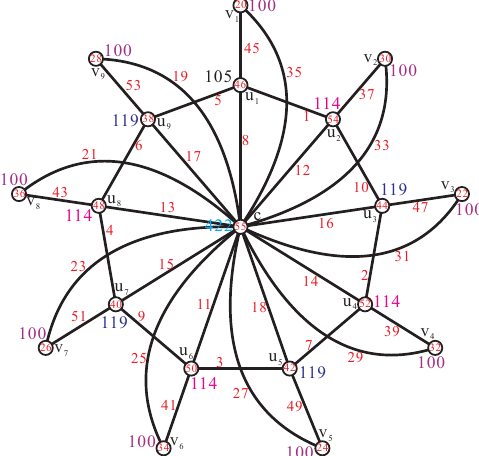
Figure 16. The local antimagic total labeling of F 9 .